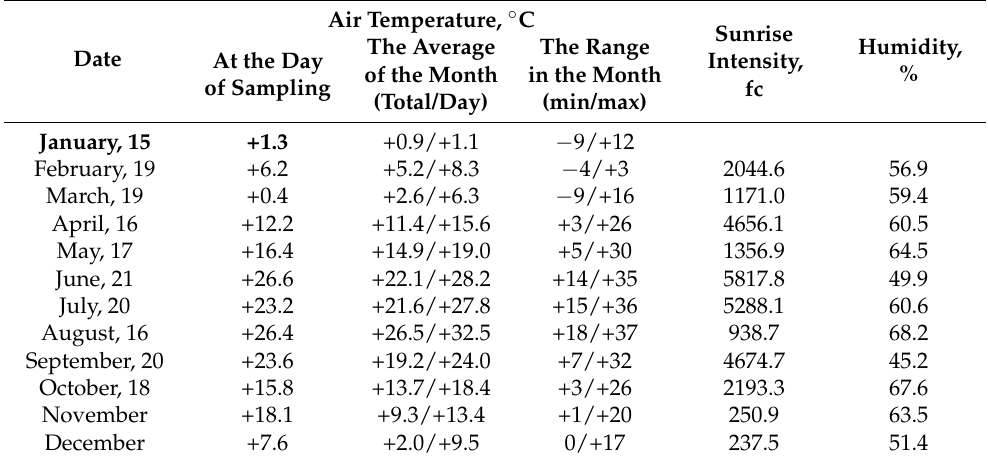
Figure 7. The level of precipitation at the studying area in 2022. Table 1. Characteristics of the meteorological parameters in the sampling period near Saki Lake in 2022.